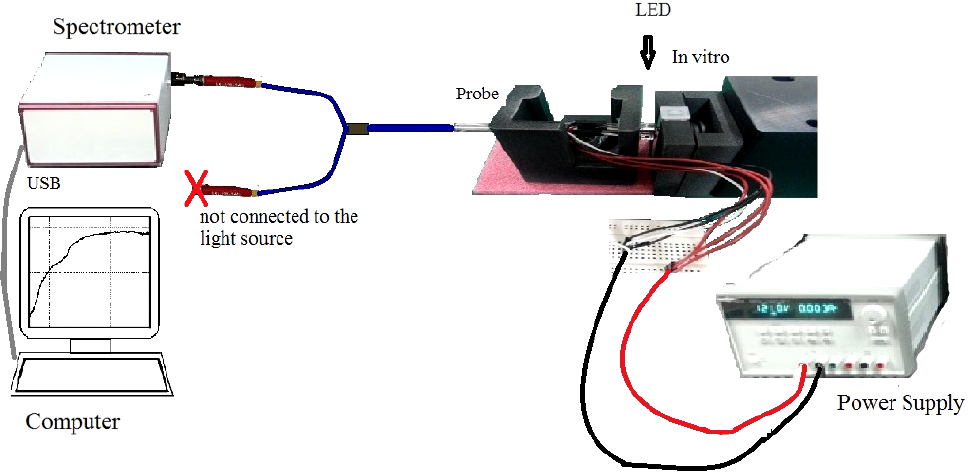
con¯guration.Fig. 1. Re°ectance setup using LED as the light source.